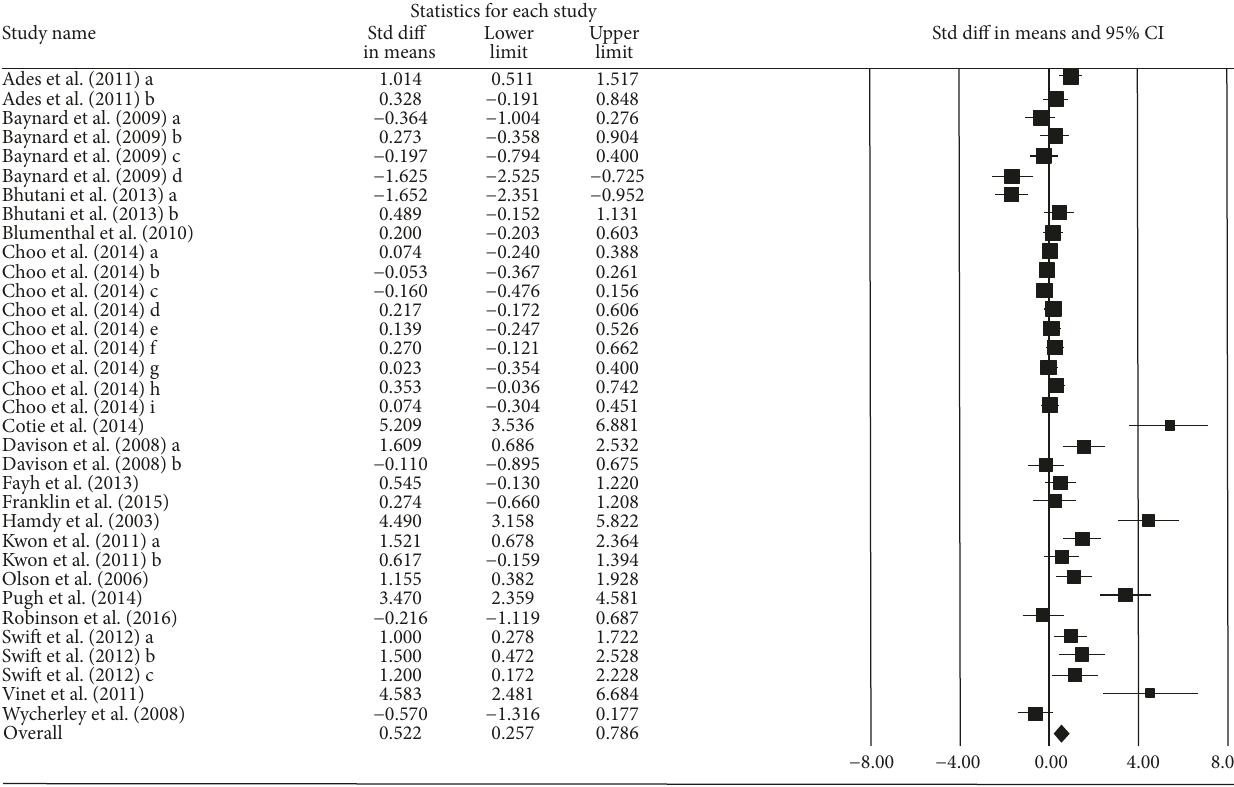
Figure 2: Forest plot illustrating effect of exercise intervention on